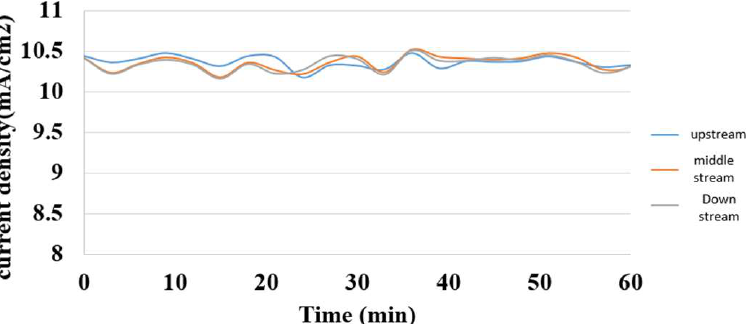
Figure 17. Internal current distribution during charging of the hydrogen/vanadium redox battery.